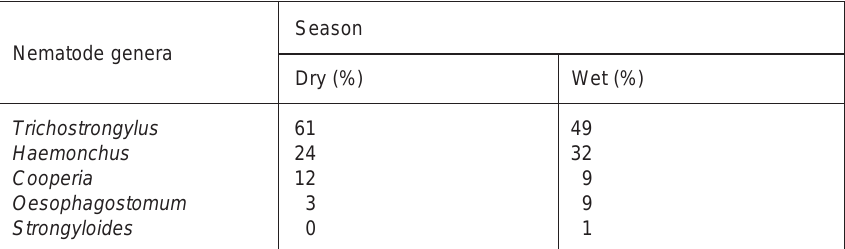
TABLE 2 The mean distribution of genera of gastrointestinal nematodes in faecal cultures from Dorper sheep during the wet and the dry season